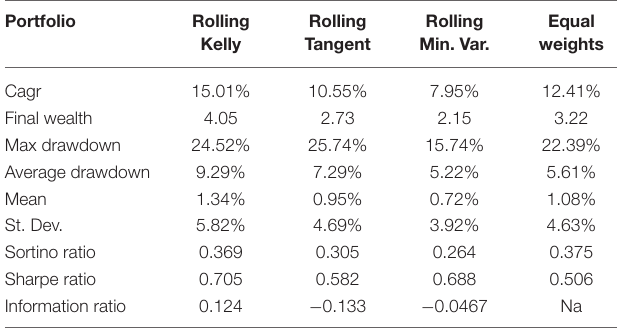
TABLE 8 | Out of sample performance of the 24-months rolling portfolios (monthly data).